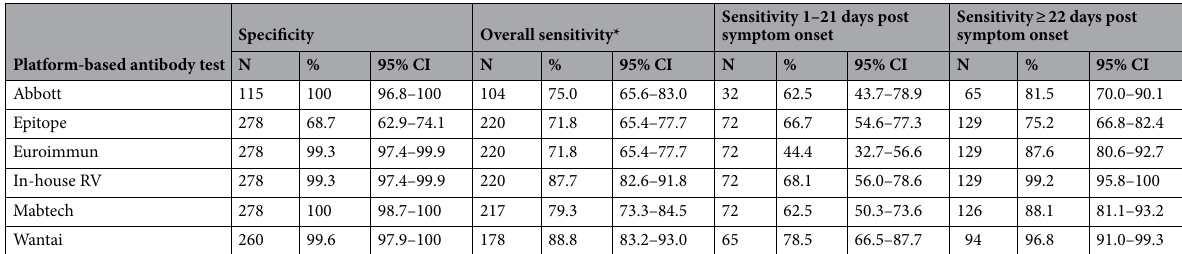
Table 2. Specificity and sensitivity of six platform-based SARS-CoV-2 antibody tests. CI confidence interval. *Independent of time between onset of COVID-19 symptoms and sampling.